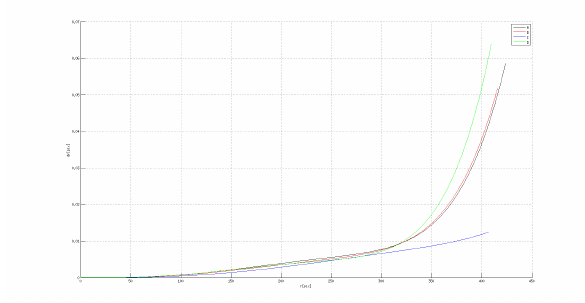
Figure 6: Radial symmetric distortion curves for all IR